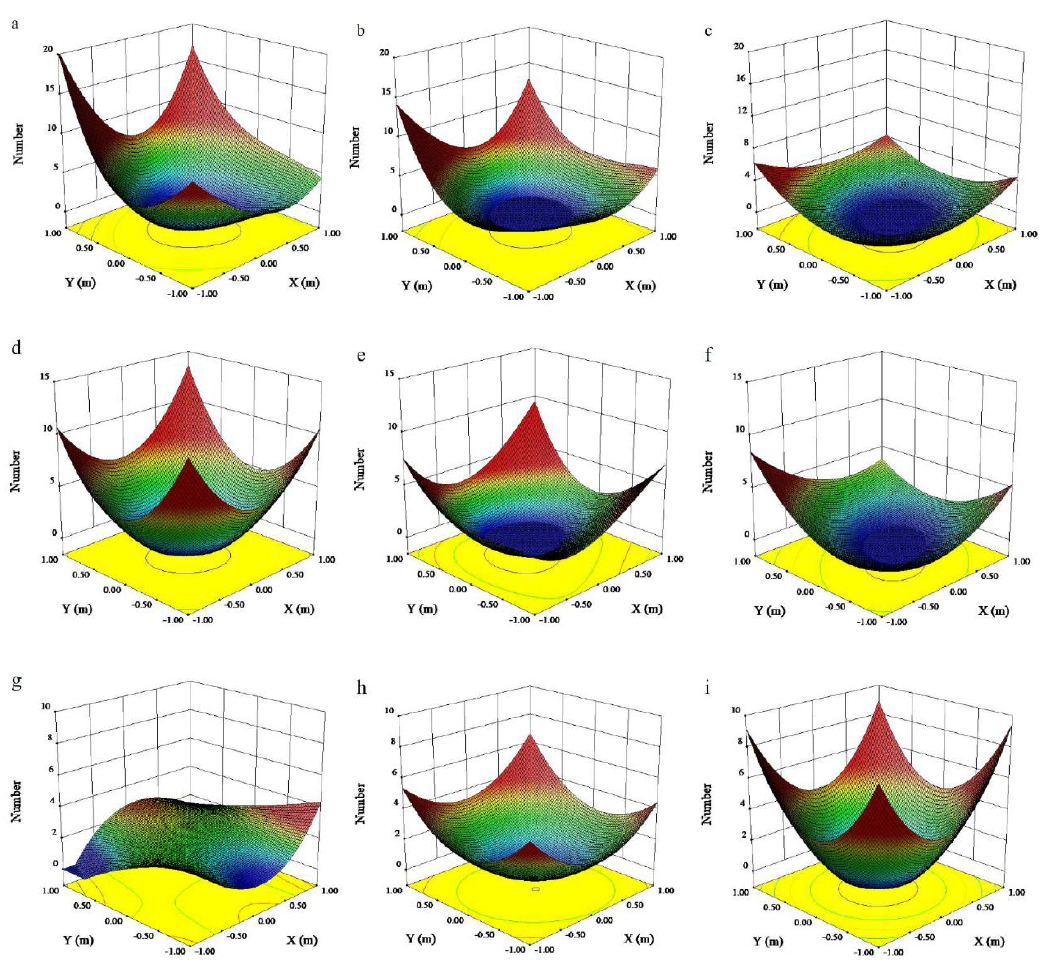
Figure 6. Distribution of the different branch types in the three layers. The x -axis is the distance in the east ( + ) and west ( − ) directions from the trunk. The y -axis shows the distance in the south ( + ) and north ( − ) directions from the trunk. The z -axis represents the number of branches. ( a ) Strong branches in the top layer; ( b ) strong branches in the middle layer; ( c ) strong branches in the lower layer; ( d ) moderate branches in the top layer; ( e ) moderate branches in the middle layer; ( f ) moderate branches in the lower layer; ( g ) weak branches in the top layer; ( h ) weak branches in the middle layer; ( i ) weak branches in the lower layer.